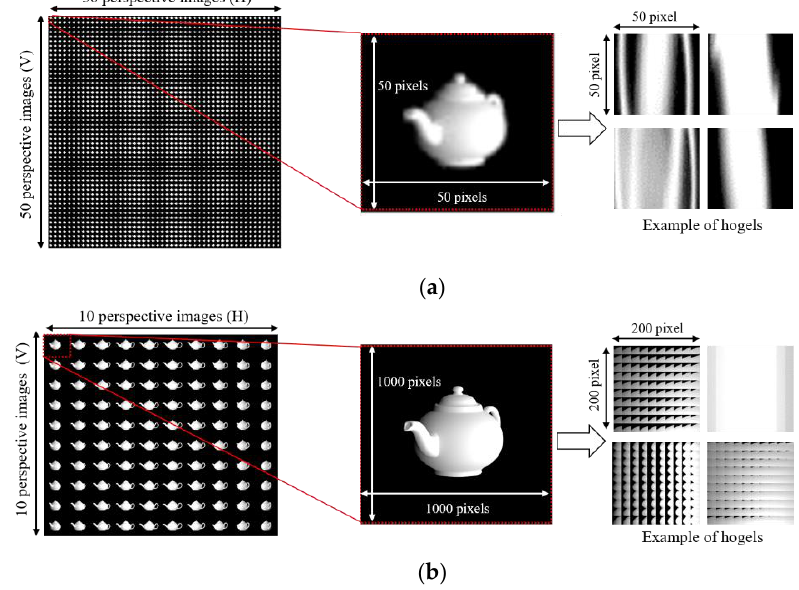
Figure 6. Comparison of rendered perspectives in terms of pixel disparity: ( a ) conventional method and ( b ) proposed method.